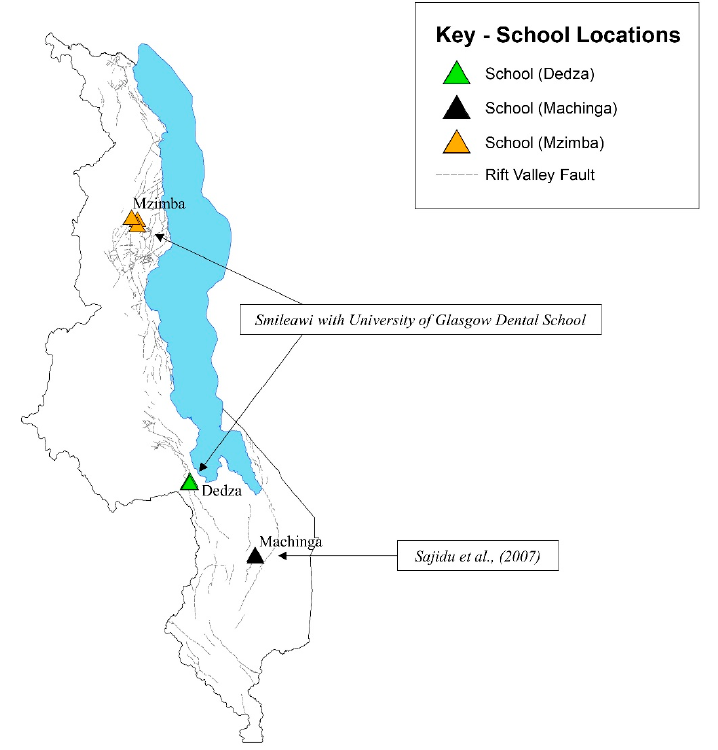
Figure 6. Map of Malawi showing locations of schools sampled during dental surveys for dental fluorosis in children. Four schools in Mzimba District and one school in Dedza District were sampled by our dental team (Smileawi and the University of Glasgow Dental School) in 2019. Two schools in Machinga District were identified from Malawi literature as being endemic severe dental fluorosis areas [10].